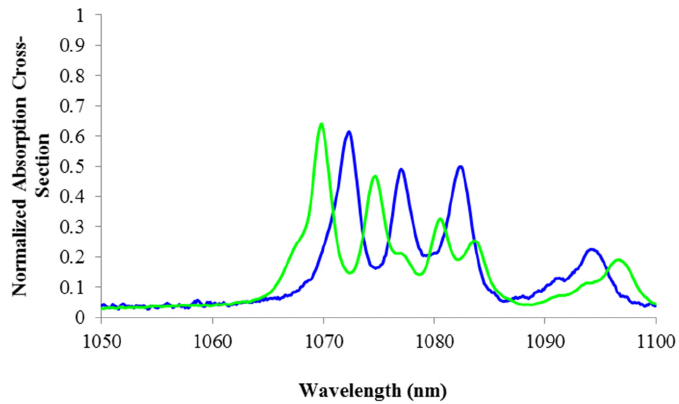
Figure 40. Normalized absorption cross-section as a function of wavelength in the region from 1050 to 1100 nm, for the Sm-doped materials Sm:YAG (green) and Sm:LuAG (blue).